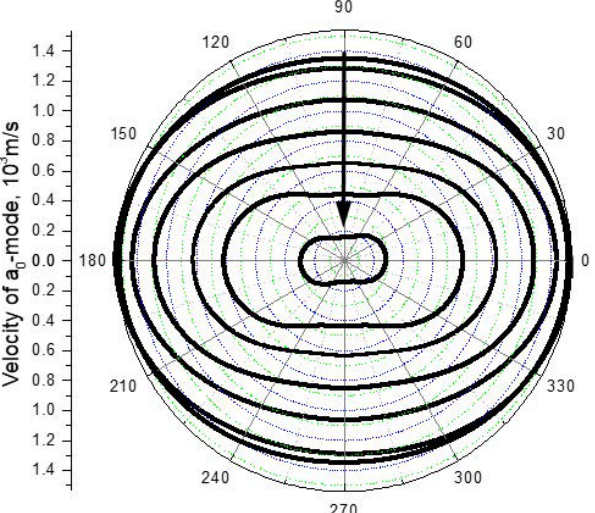
Figure 1. Calculations of in-plane phase velocity anisotropy. ( a 0 mode) in UD-CFRP: consecutive values of ( f · D ) parameter for the curves in the direction of arrow are: 4000, 3000, 500, 250, 175, 50 and